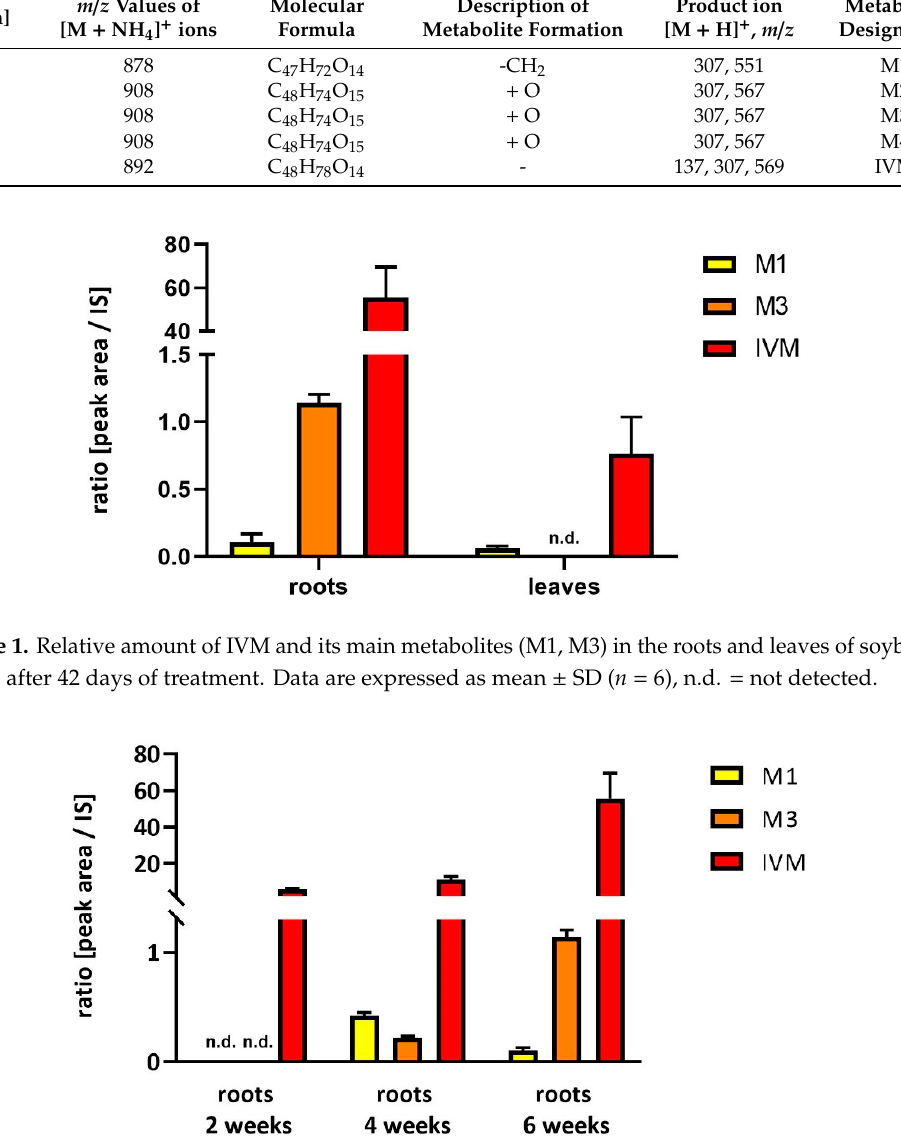
Figure 2. Time dependence of IVM uptake and metabolites formation in soybean roots. Relative amount of IVM main metabolites (M1 and M3) and IVM. Data are expressed as mean ± SD ( n = 6), n.d. = not detected.